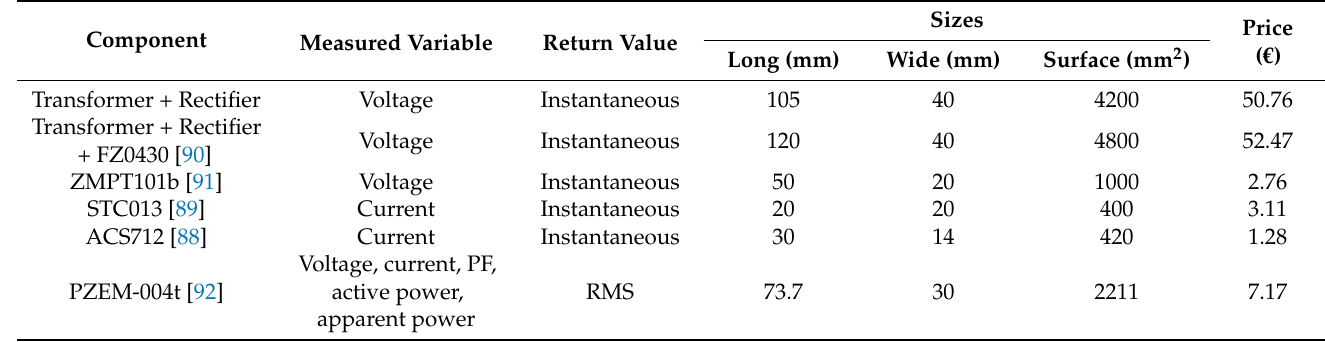
Table 4. Electrical sensors comparison.